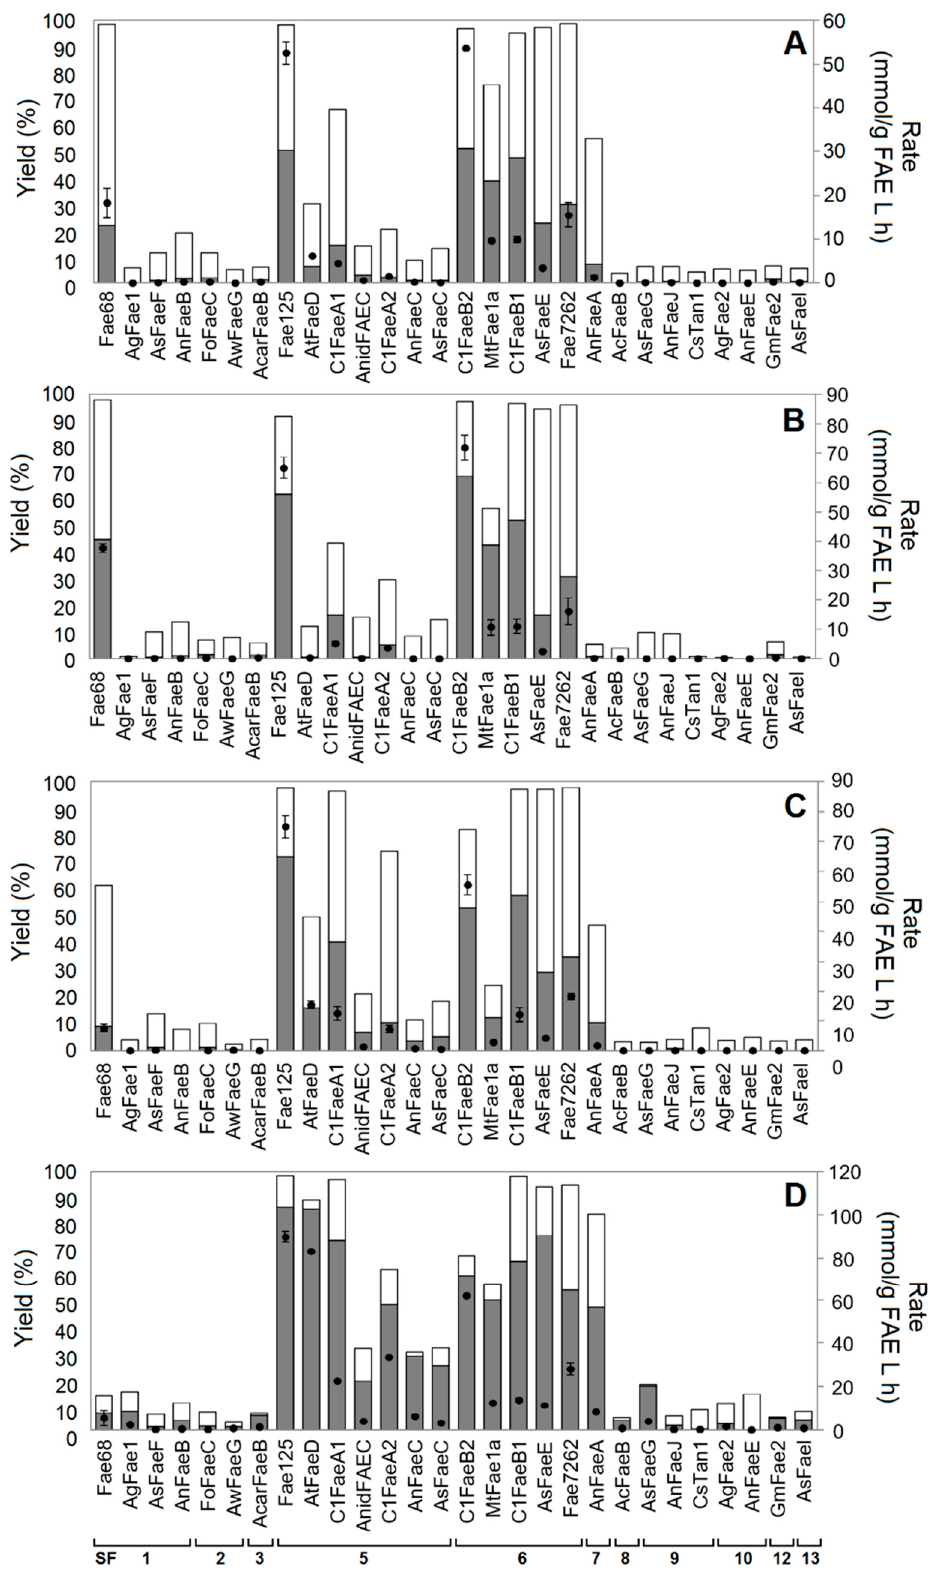
Figure 2. Synthesis of ( A ) PFA, ( B ) PCA, ( C ) BFA, and ( D ) GFA. Reaction conditions: 50 mM donor (VFA or VCA), 800 mM acceptor, 0.2 mg protein mL − 1 , 53.4:43.4:3.2 v / v / v n -hexane: t -butanol: buffer, 45 °C, no agitation, 24 h of incubation. Grey column: transesterification yield; white column: hydrolysis yield; black circle: specific rate of transesterification. The error bars represent the standard deviation between two duplicates.